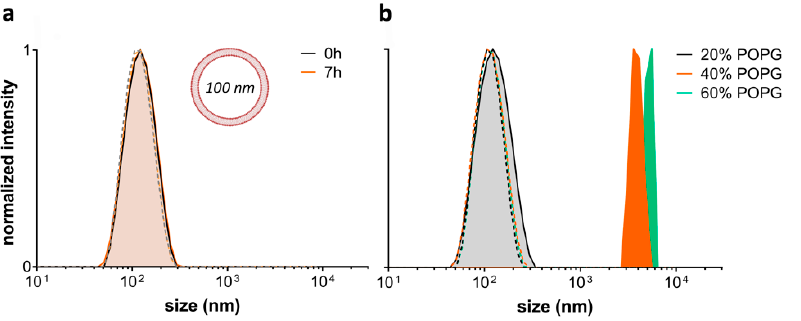
Figure 5. Effect of L-OE-h on model liposomes composed of phosphatidylcholine (POPC) ( a ) and POPC with varying phosphatidylglycerol (POPG) content ( b ). Vesicle sizes were measured by DLS at 25 ° C. Dashed lines are the respective controls without polymer.